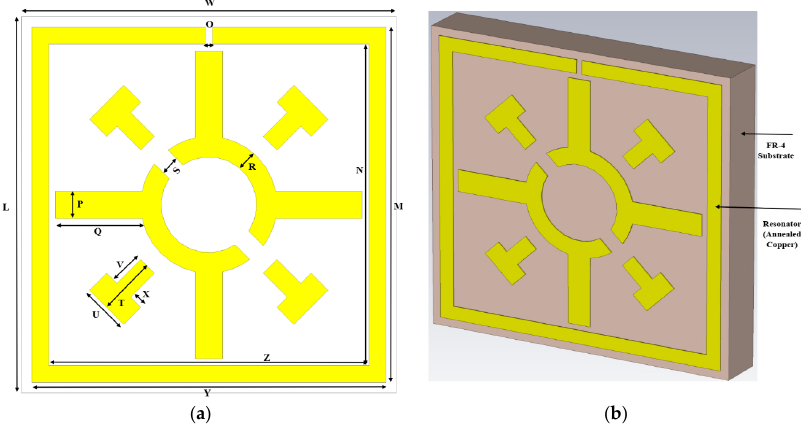
Figure 1. Different views of the unit cell: ( a ) Top view, ( b ) Isometric view.